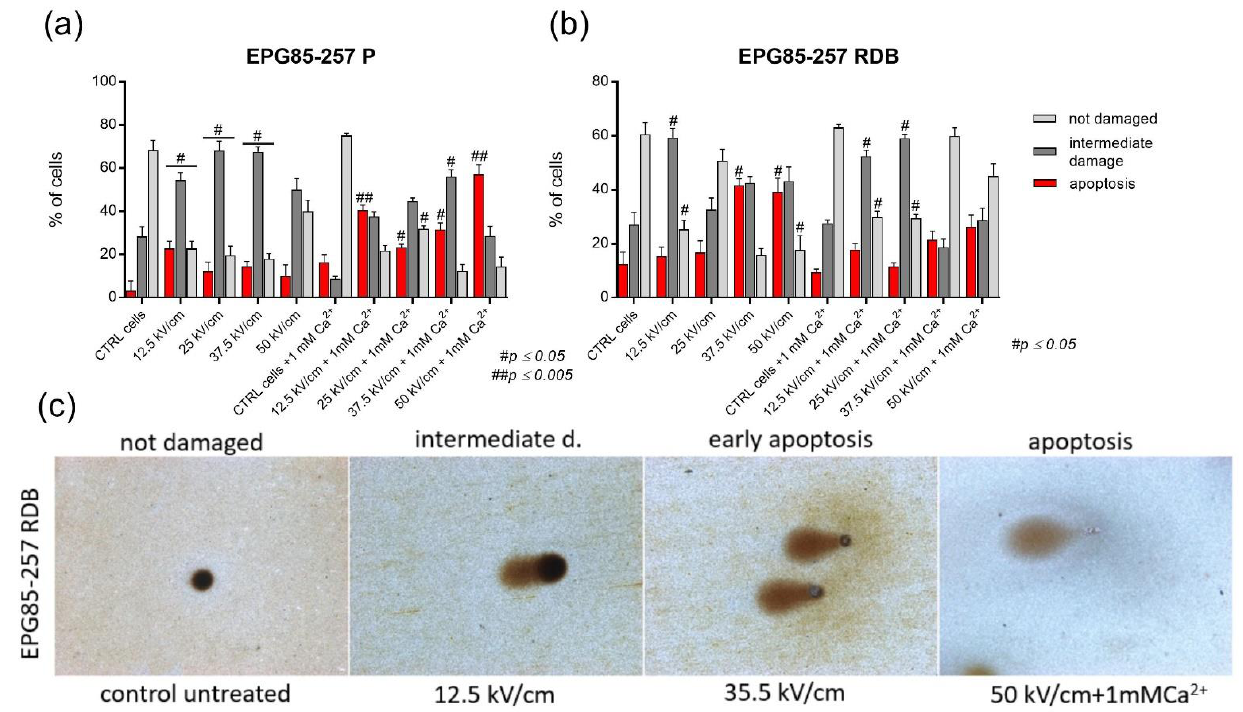
Figure 8. Apoptosis analysis by comet assay in human gastric cancer cells ( a ) P-sensitive, and ( b ) RDB—resistant) after nsPEF protocols, ( c ) exemplary microphotographs of evaluated comets. Magnification 600 × .